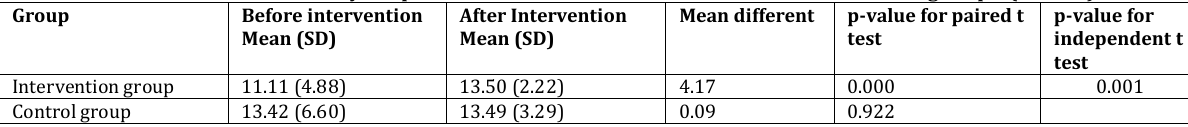
Tabel 2. Differences in community empowerment before and after intervention in both groups